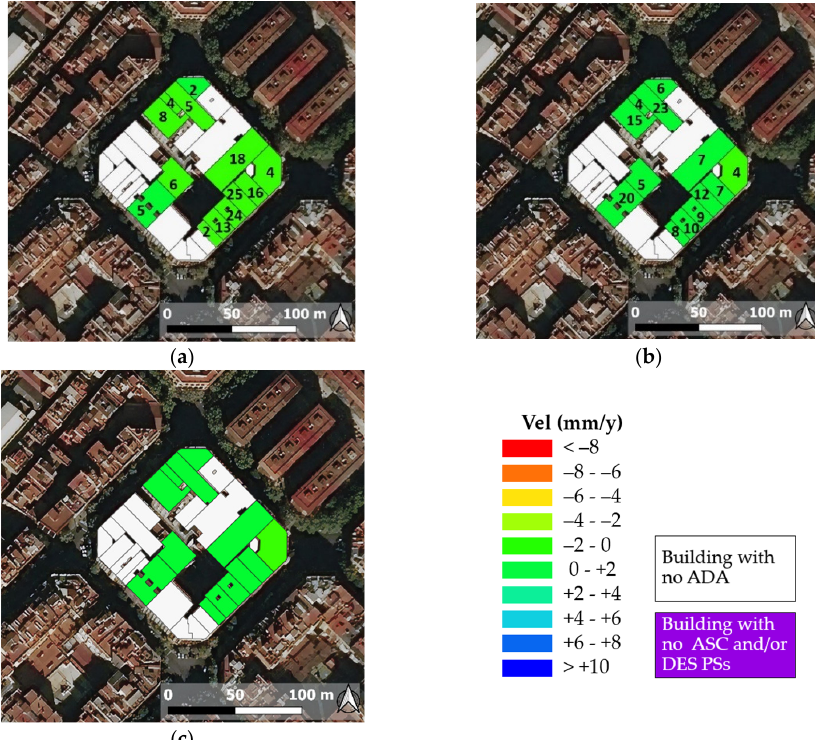
Figure 10. Maps of average values of mean deformation velocity along ( a ) ascending and ( b ) de- scending orbit, and ( c ) map of V EW /v components for one of the quadrangular blocks of the Eixample . The labels indicate the number of PSs used to compute the average mean deformation velocities for each specific building.